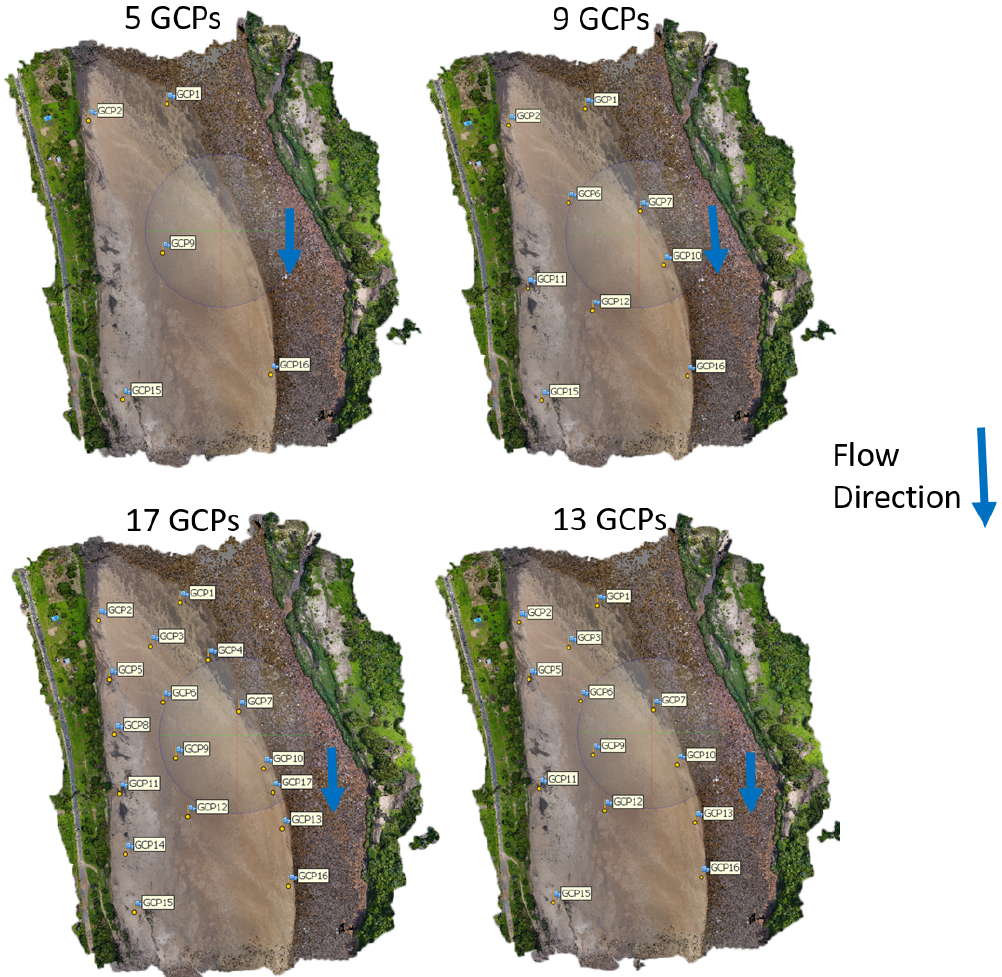
Figure 7. GCP marker distribution along the